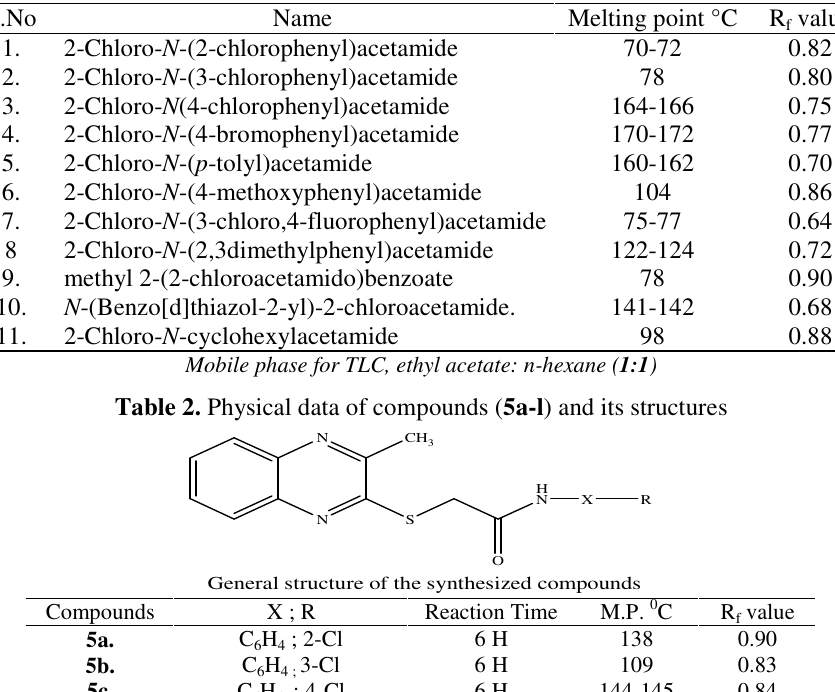
Table 1. Physical data of 2-chloro- N -(substituted phenyl)acetamides